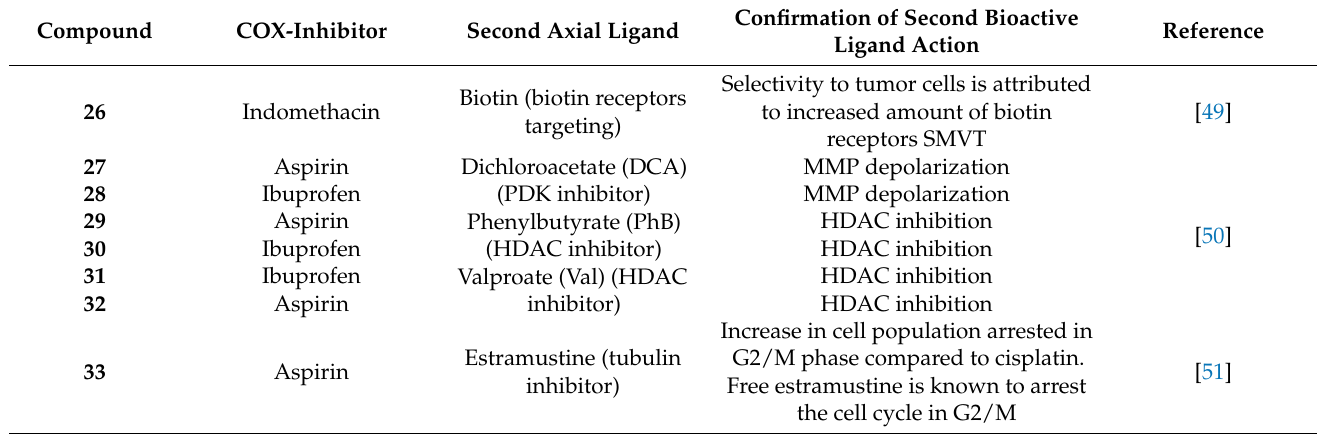
Table 12. Triple action platinum(IV) prodrugs with NSAIDs and another bioactive ligands in the axial position.